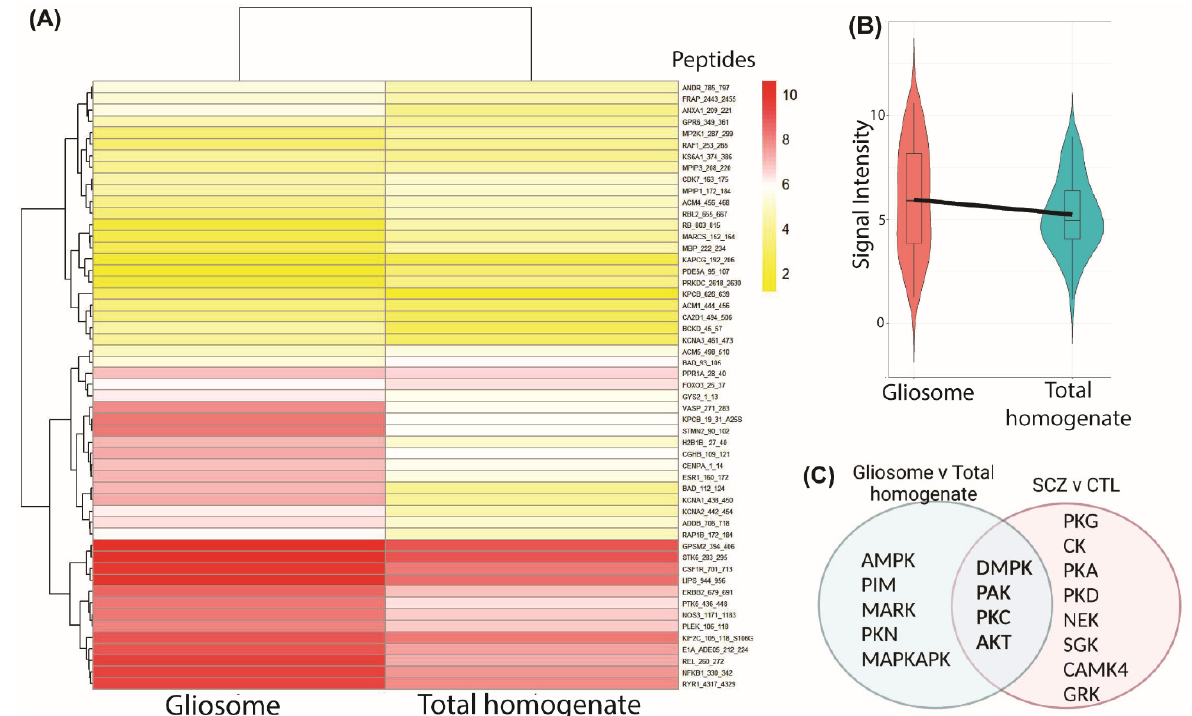
Figure 5. ( A ) Heatmap of Pamgene12 kinome array peptide phosphorylation intensity in a gliosome fraction and total homogenate from postmortem dorsolateral prefrontal cortex. A greater number of peptides are phosphorylated in the gliosome fraction suggesting enrichment of serine/threonine protein kinase activity in this sample. ( B ) Violin plot of peptide phosphorylation signal intensity in gliosome fraction and total homogenate. ( C ) Following peptide mapping, a number of common kinases with differential activity (L2FC +/ − 0.2) in the gliosome relative to total homogenate samples and a previous study of postmortem schizophrenia (SCZ) and control (CTL), were identified.